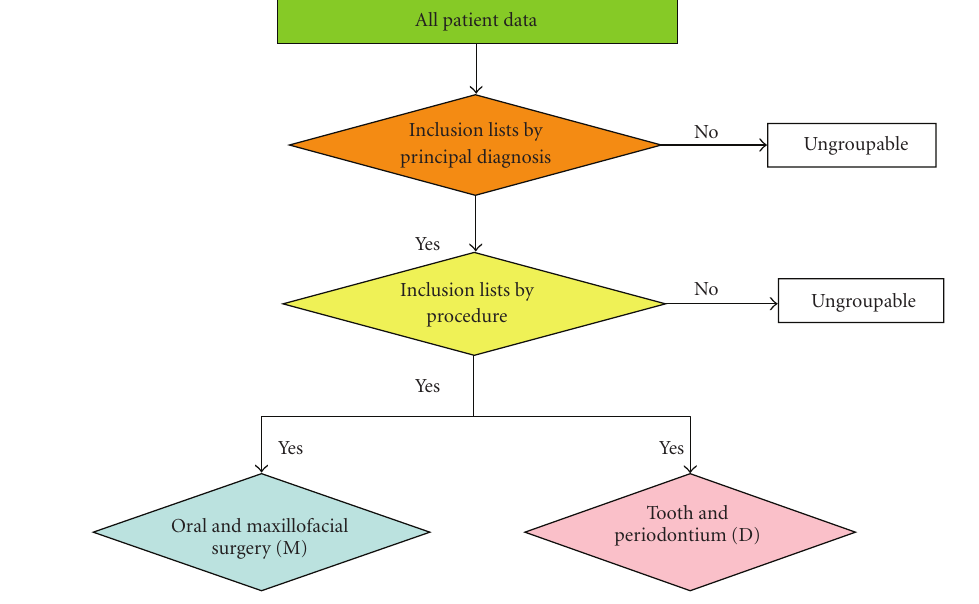
Figure 1: Diagram presents the steps one and two.